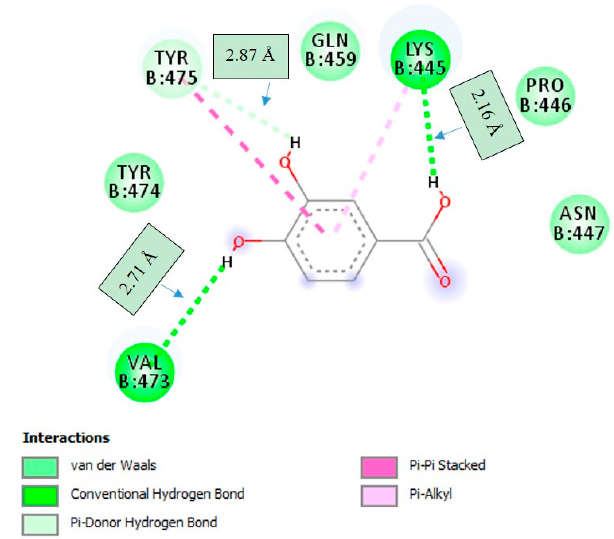
Figure 7. 2D interaction diagram of protocatechuic acid (PCA) in the active site of Helicobacter pylori urease (HPU; PDB code: 1E9Y). Only those amino acid residues involved in HPU stabilization are shown. Hydrogen bonding interactions with amino acid residues at corresponding distances are shown.